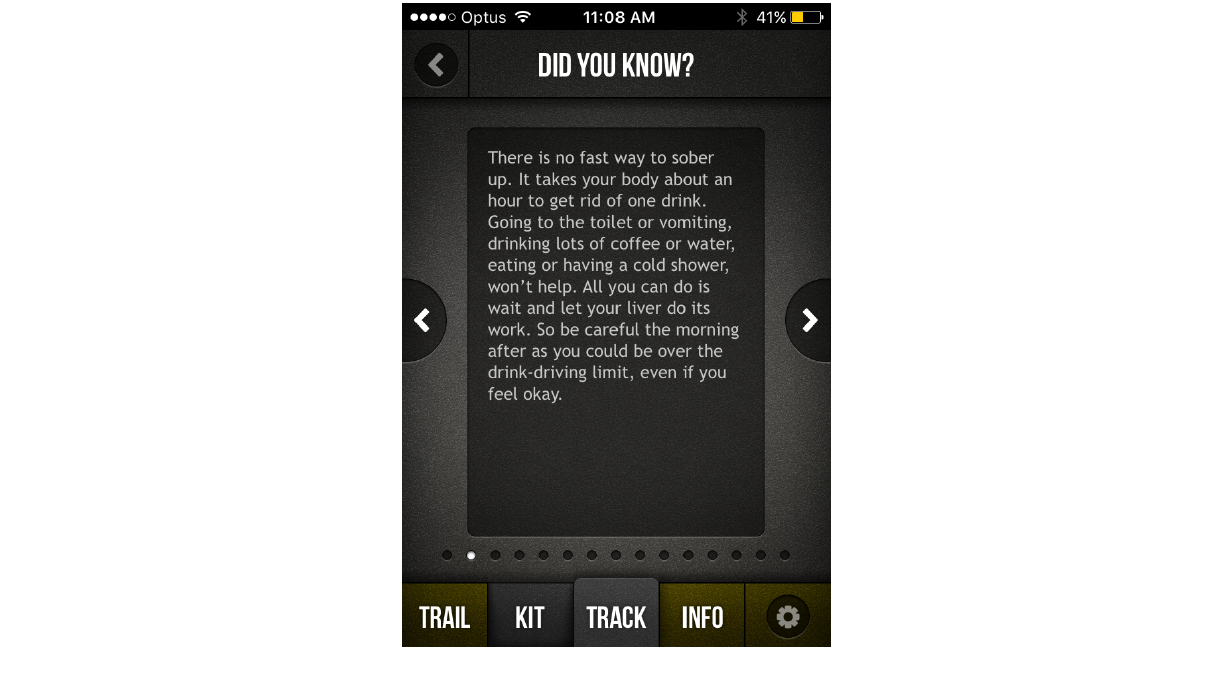
Figure 4. IntelliDrink Screenshot